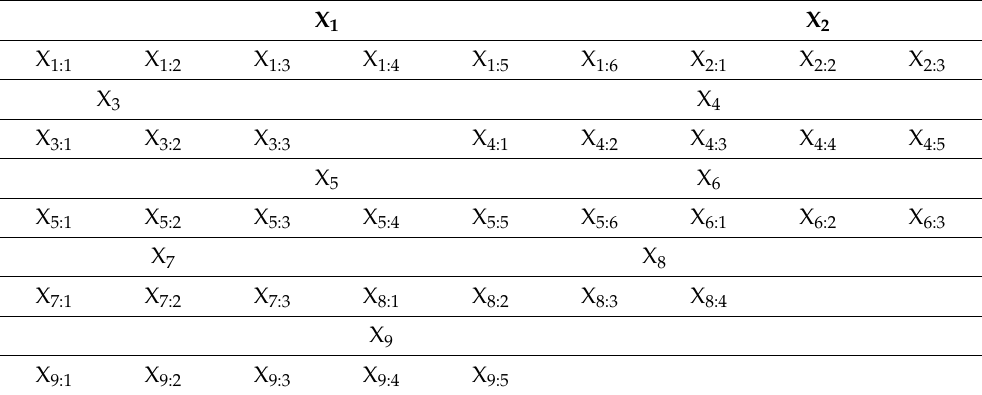
Table 4. Multi-input–output